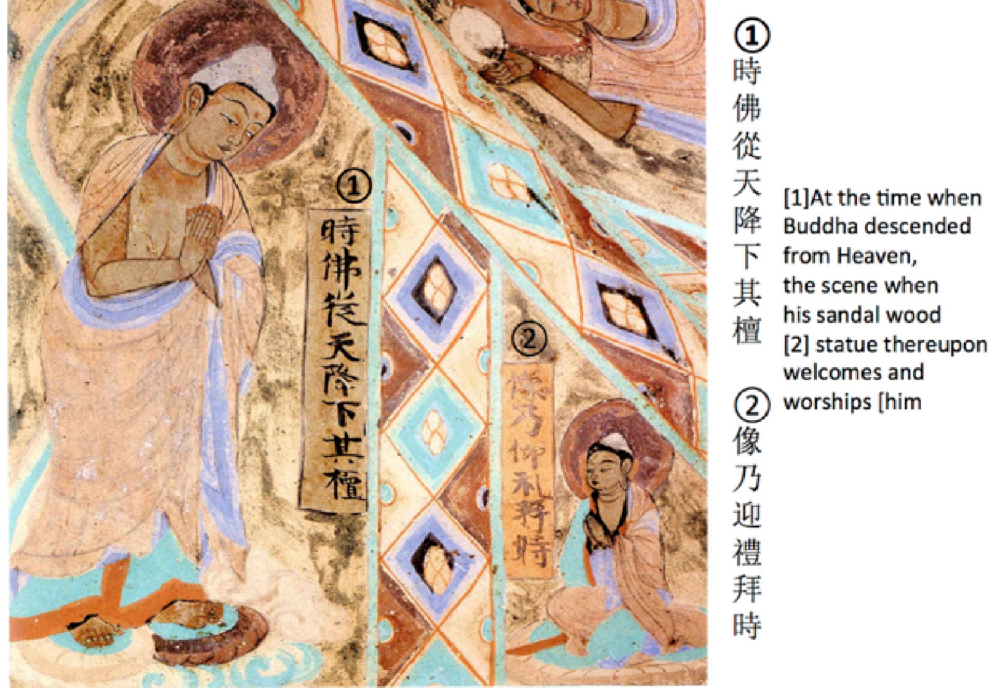
Śākyamuni greeting his statue when returning from Heaven (adapted from Sūn Xiūshēn 2000, 23, ill.5). The motif (the depiction of which fits well into the corners of slanted Buddha niche ceilings) appears also in D-MG 237 from the mid-Táng period; there, the slanted ceilings of the Western niche are covered by more than 30 Auspicious